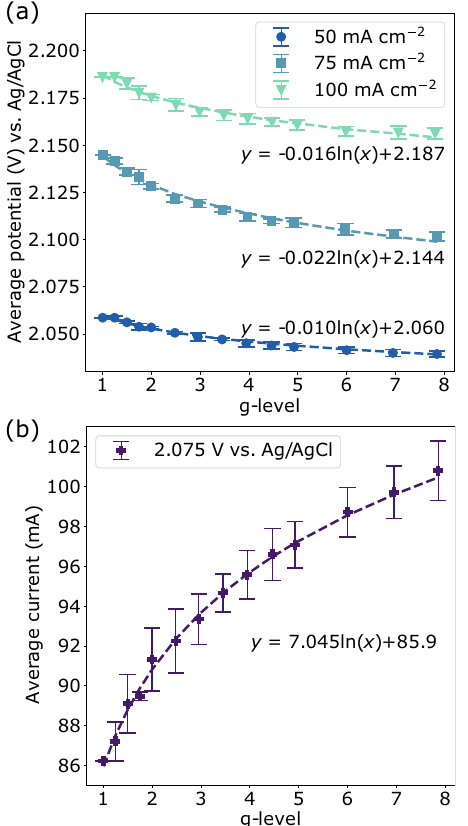
Fig. 2 Hypergravity gas-evolving electrolysis (1 – 8 g). The average potential during galvanostatic experiments ( a ) and average current during potentiostatic experiments ( b ) with hypergravity conditions achieved using a centrifuge. Error bars represent the standard error of the mean. To remove the in fl uence of cell-speci fi c shifted baselines, the average % change from 1 g for each g-level was applied to the mean 1 g value. R 2 values are >0.98 for all the fi tted trends shown. Source data are provided as a source data fi